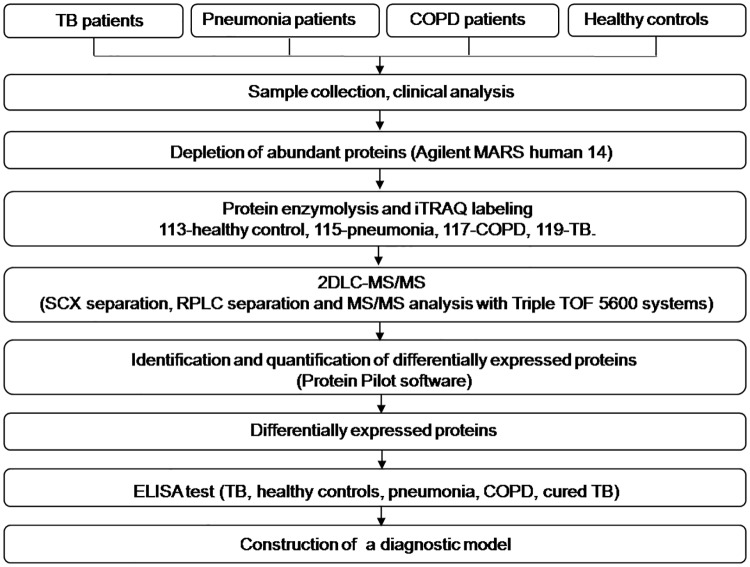
Flowchart of the experimental design.Differentially expressed proteins were identified and quantified by applying iTRAQ-2DLC-MS/MS technology and by ELISA.